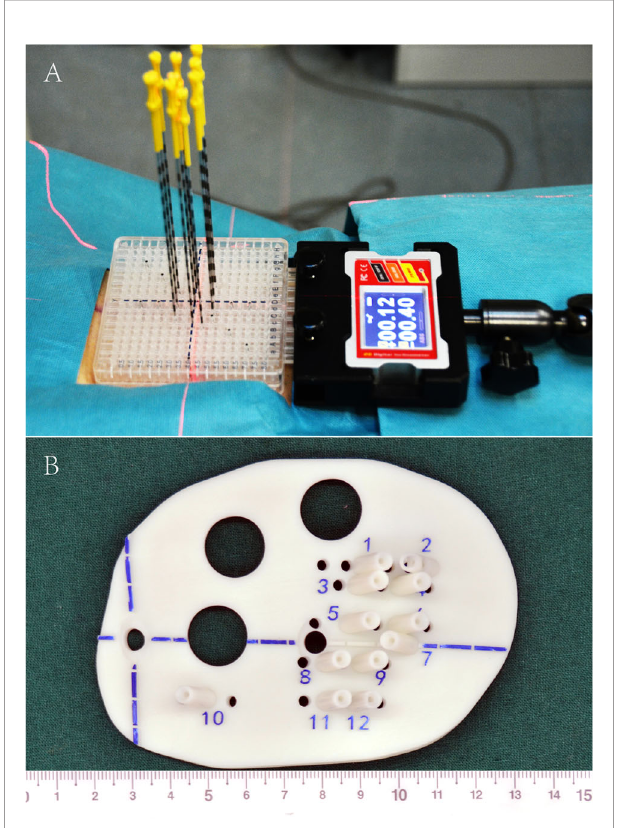
FIGURE 1 | 3D printing co-planar template (A) and 3D printing non-co- planar template (B) .